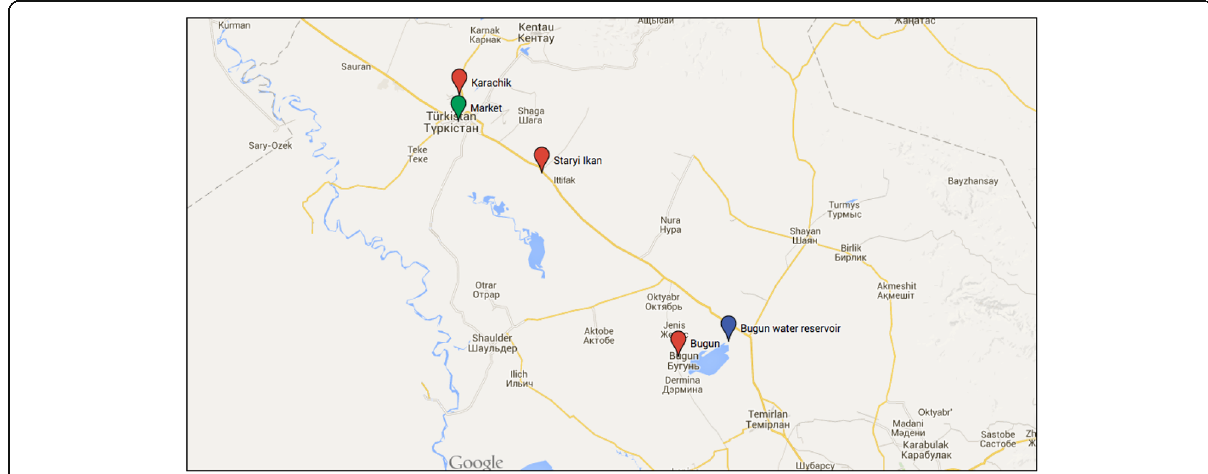
Fig. 1 Lower Syr Darya Basin, Turkestan Region, South